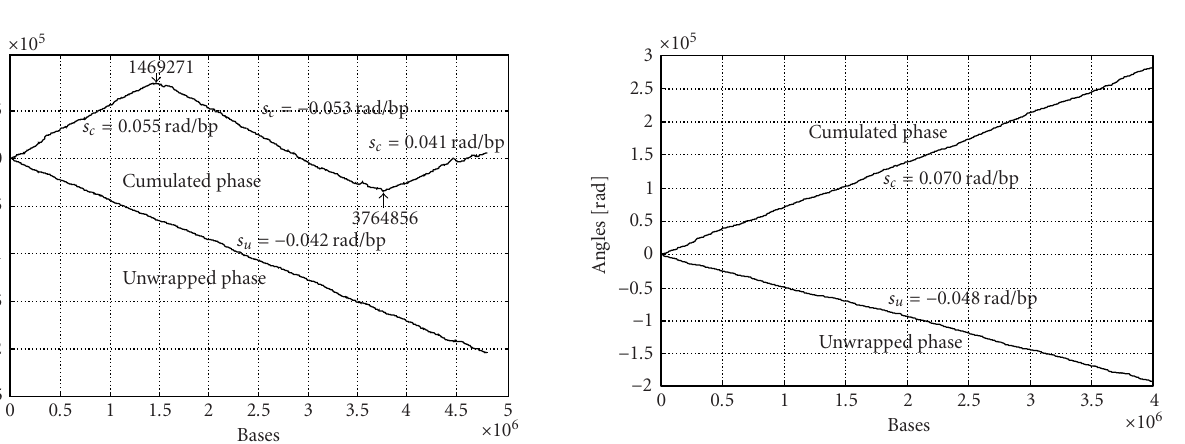
Figure 5: Cumulated and unwrapped phases of the genomic signal for the concatenated 4393 reoriented coding regions (3999478 pb) of Salmonella typhi genome [13] (accession AL5113382 [12]).